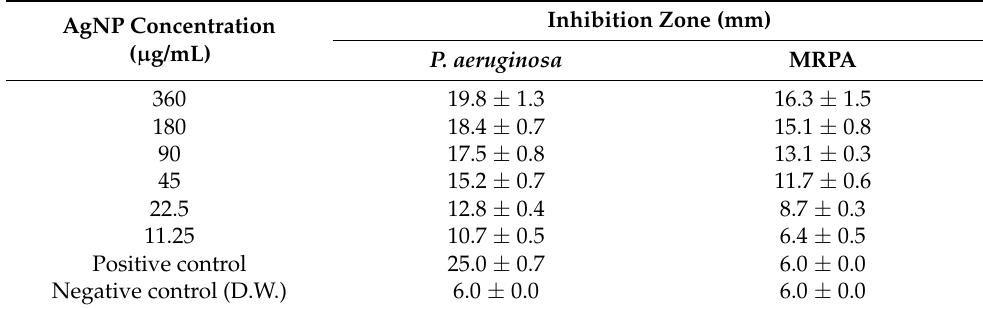
Figure 6. Antibacterial effects of AgNPs using A. catechu against P. aeruginosa and multidrug-resistant Pseudomonas aeruginosa (MRPA). ( a , b ): inhibition zone of AgNPs against P. aeruginosa . ( c , d ): inhibition zone of AgNPs against MRPA. The AgNP treatment concentrations were 360, 180, 90, 45, 22.5, and 11.25 µ g/mL. Table 4. Diameter of inhibition zones of AgNPs using A. catechu against P. aeruginosa and